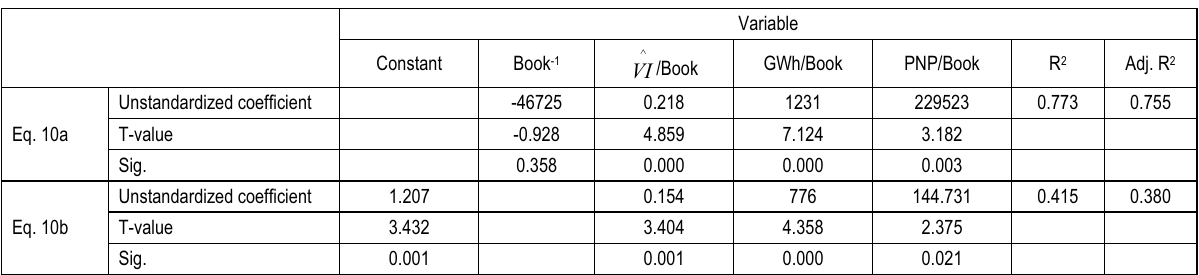
Table 6. The regression estimated (equation (10a)) is: and a version with traditional constant term (10b)